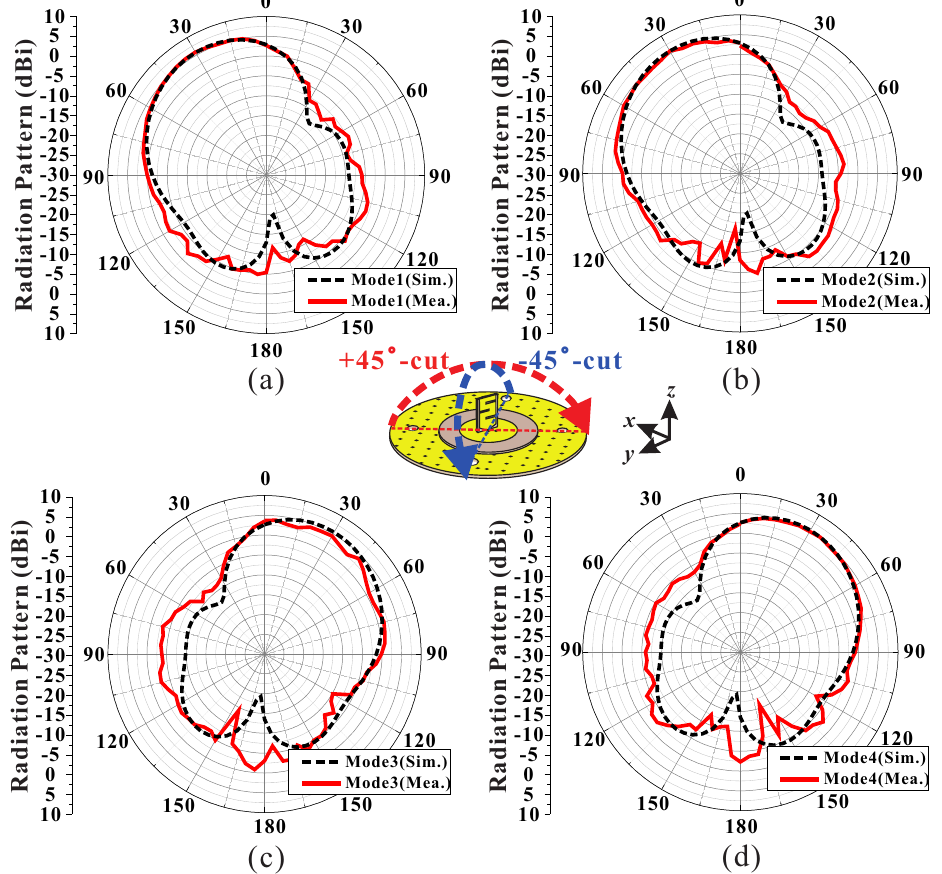
Figure 5. Simulated and measured radiation patterns at the input modes: ( a ) Mode 1 ( + 45 ◦ elevation plane), ( b ) Mode 2 ( − 45 ◦ elevation plane), ( c ) Mode 3 ( + 45 ◦ elevation plane), and ( d ) Mode 4 ( − 45 ◦ elevation